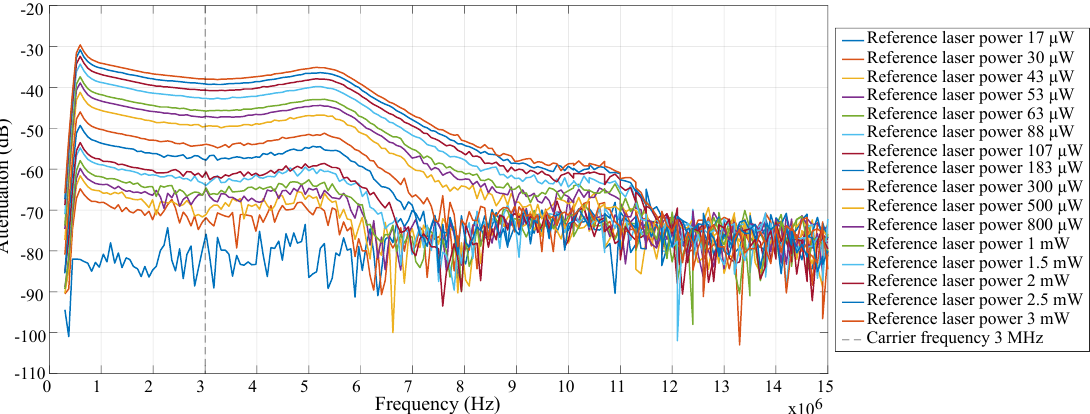
Figure 39. Attenuation characteristics of Octavia tail-light during fog dissipation –in scenario 5 -